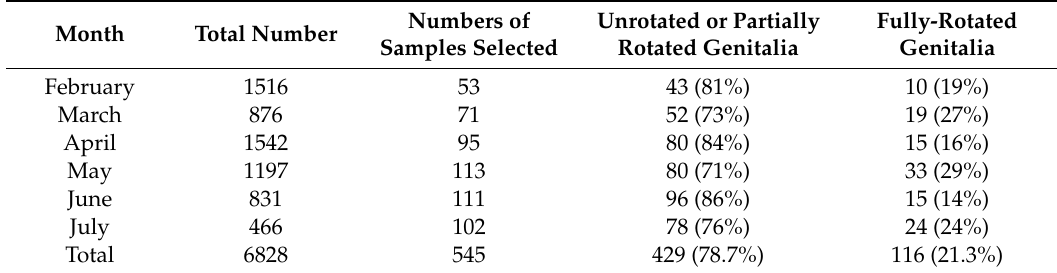
Table 3. Proportion of external genitalia rotations of male